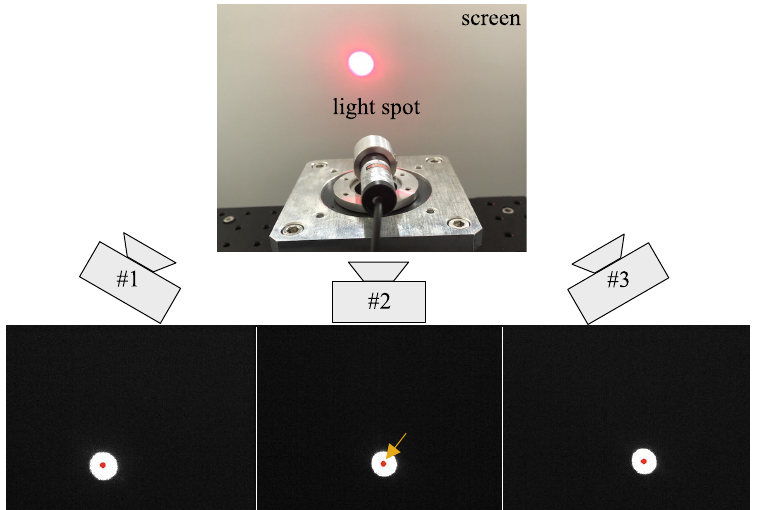
Figure 9. Example of image capturing and centroid acquisition. The centroid of the light spot (red dot) was clearly detected at each camera